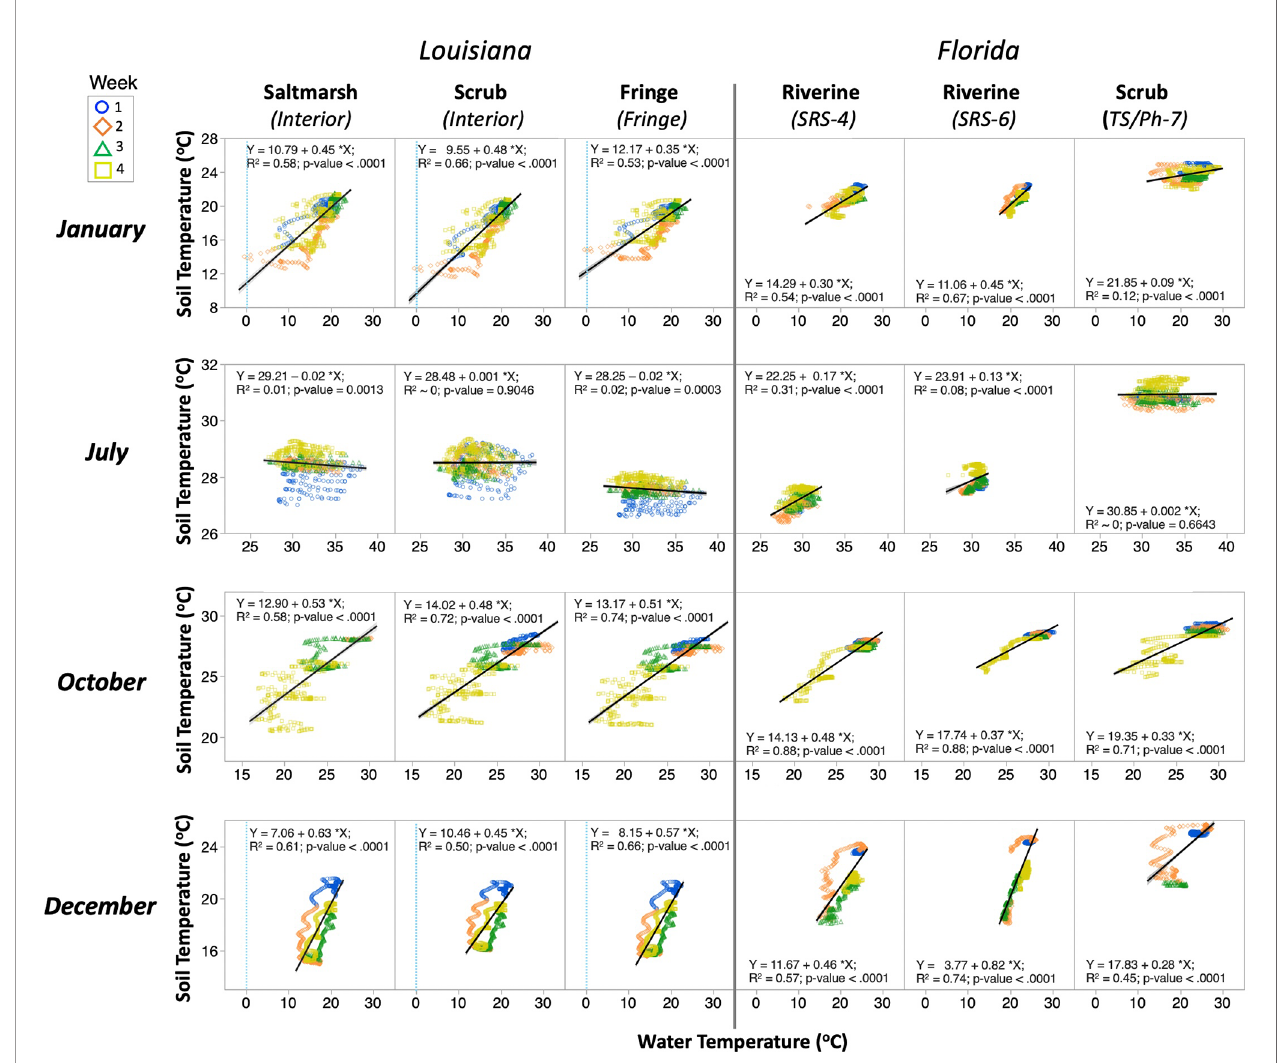
FIGURE 5 | As in Figure 4 , but for linear regressions between hourly water and soil temperature recorded in selected wetland sites and months in